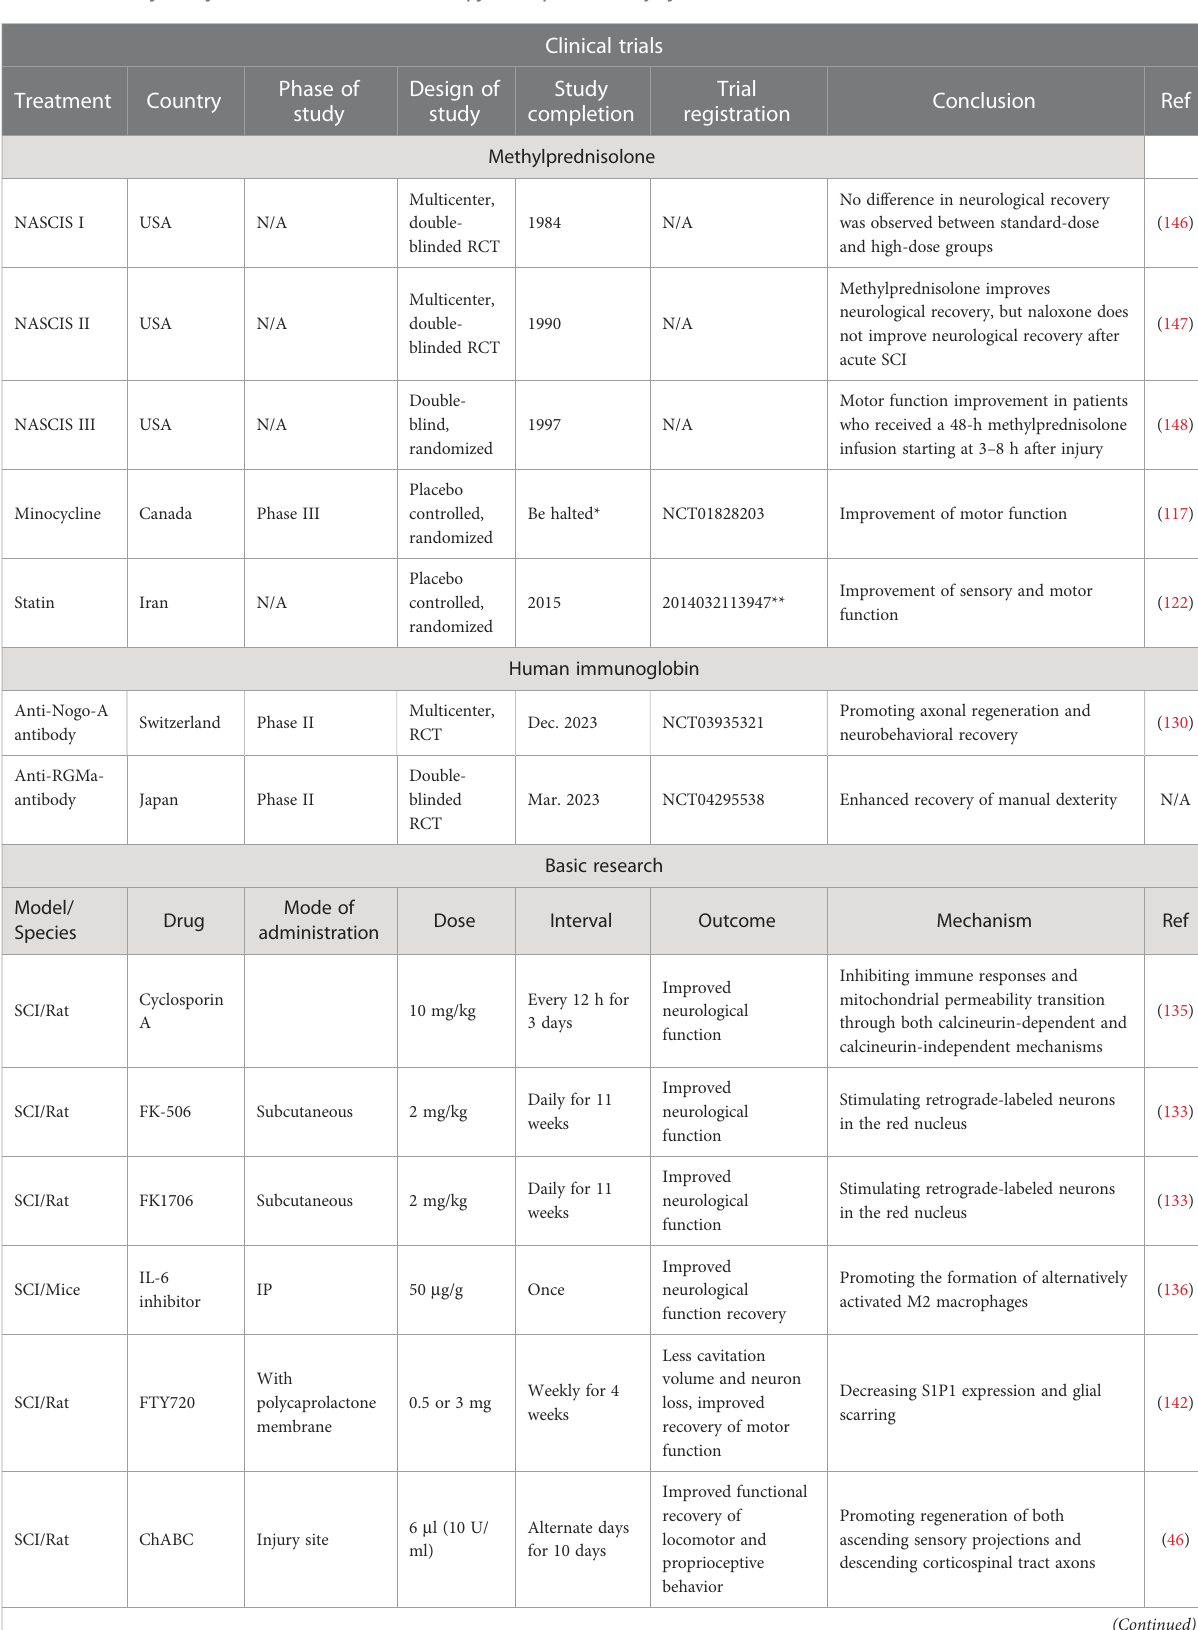
TABLE 1 Summary of key clinical trials on immunotherapy after spinal cord injury